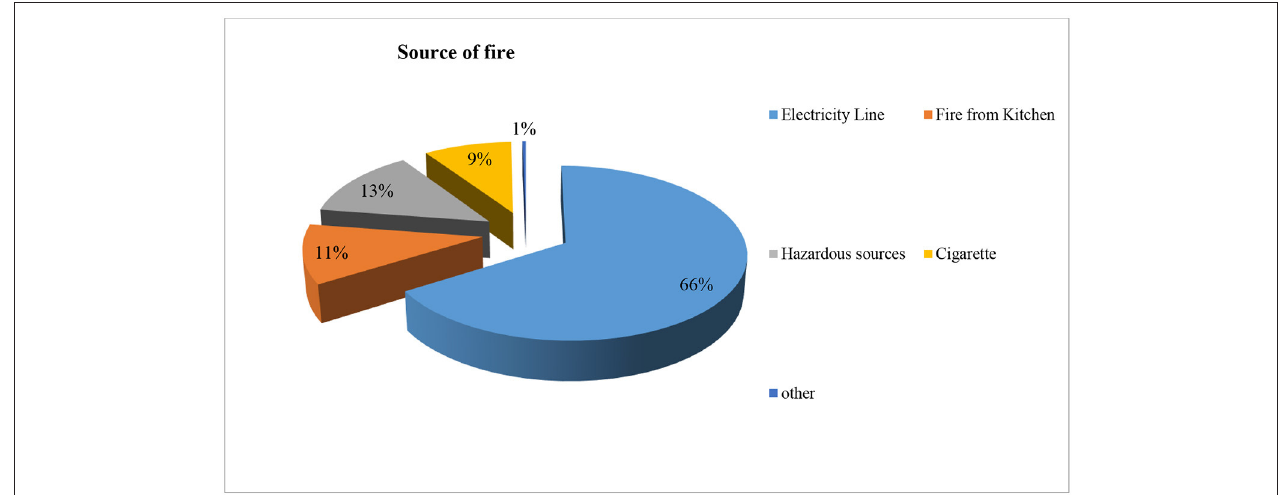
FIGURE 6 | Percentage of causes of fire